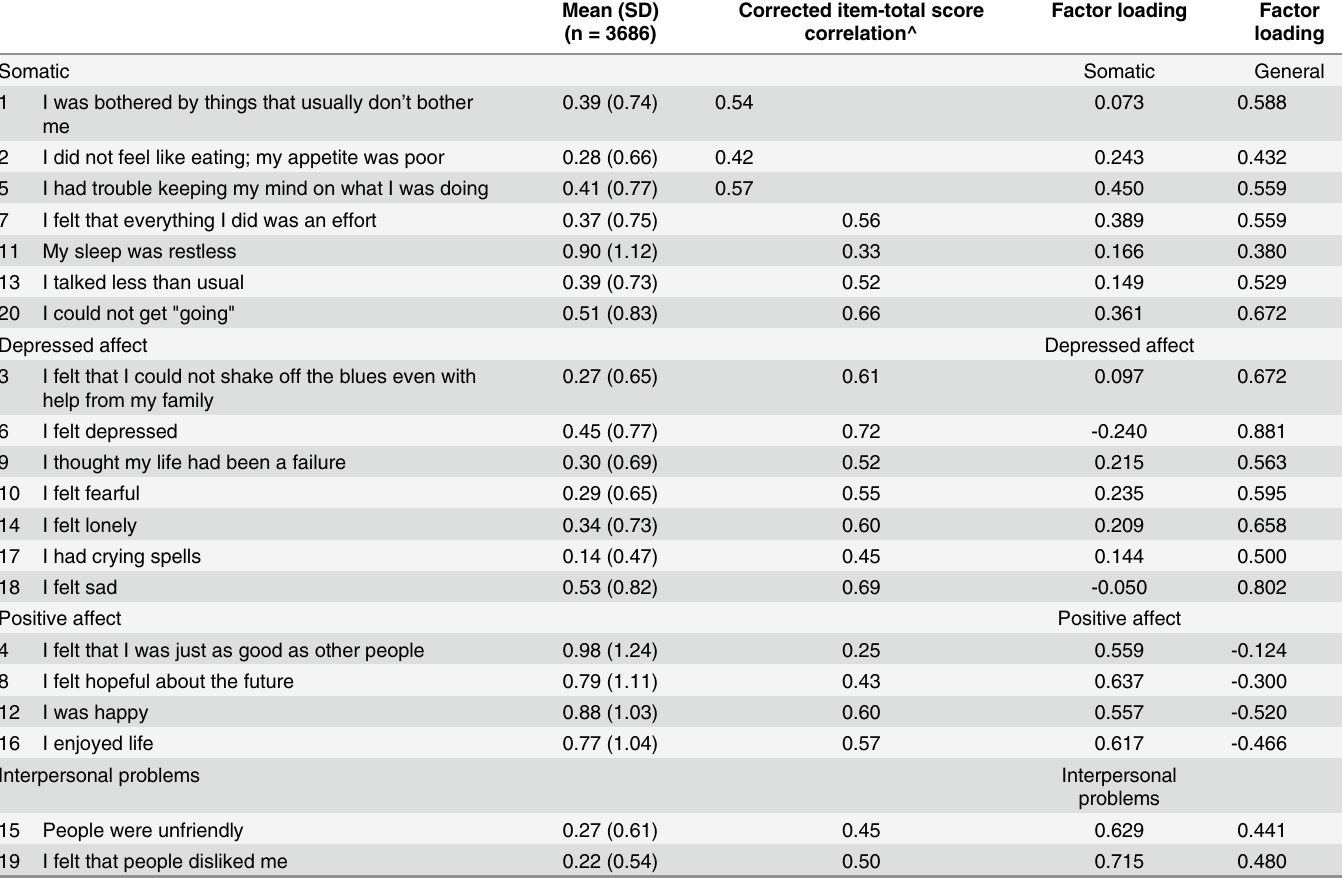
Table 2. Factor structure and internal construct validity of the CES-D.